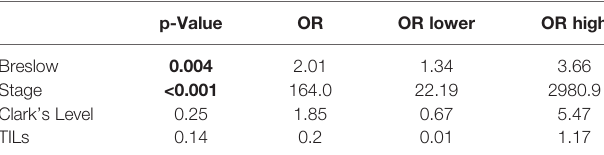
TABLE 4 | OR and p-value for overall survival of the Cox multivariate analysis. p-Value OR OR lower OR high